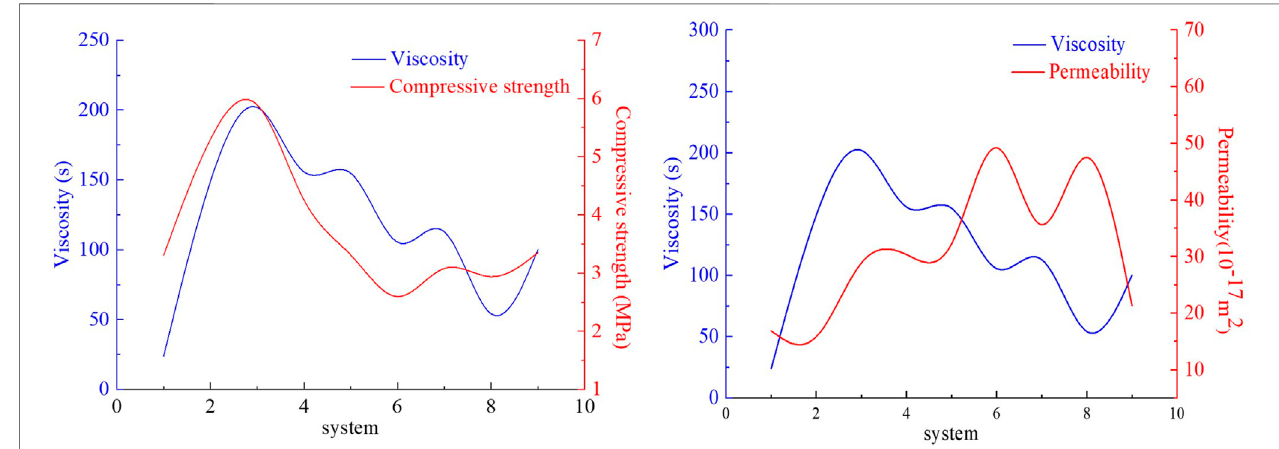
FIGURE 8 | In fl uence curves of viscosity – compressive strength and viscosity – permeability under orthogonal experiment system.